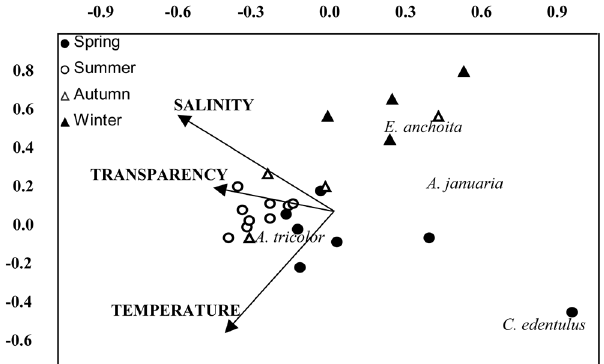
Fig. 4. Canonical correspondence analysis ordination diagram of adults Engraulidae abundance data, with